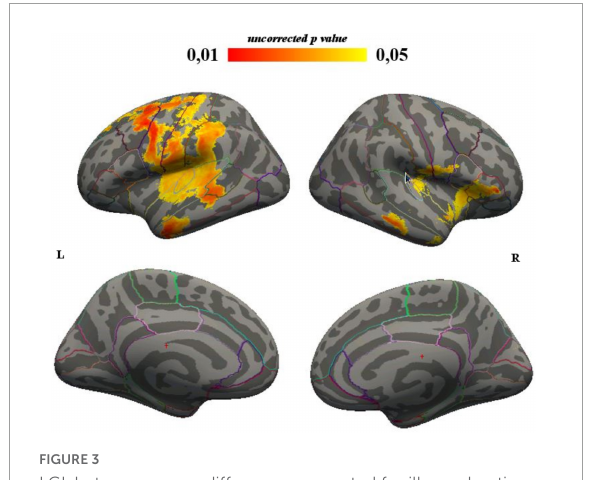
Main involved structures (number of significant vertices)